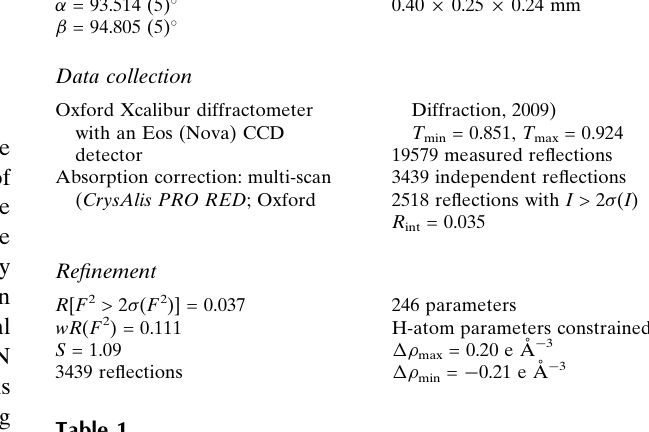
Hydrogen-bond geometry (A˚ , (cid:2)